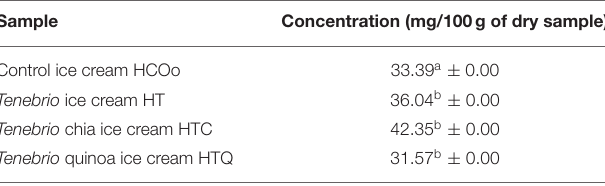
TABLE 6 | Cyanidin chloride concentration upon a dry basis of the formulations.